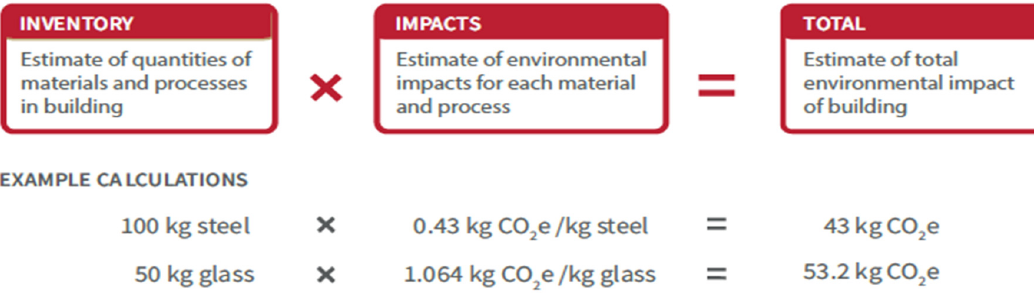
Figure 4. Simple example of LCA calculation process [61].